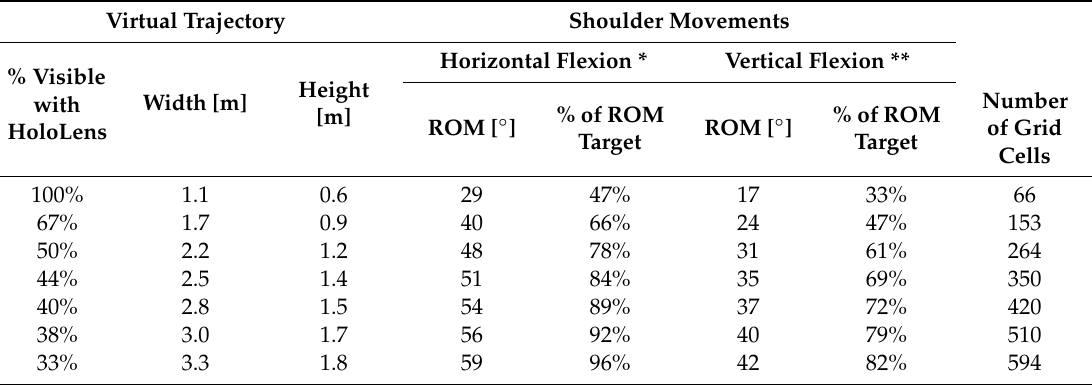
Table 1. Virtual trajectory sizing and